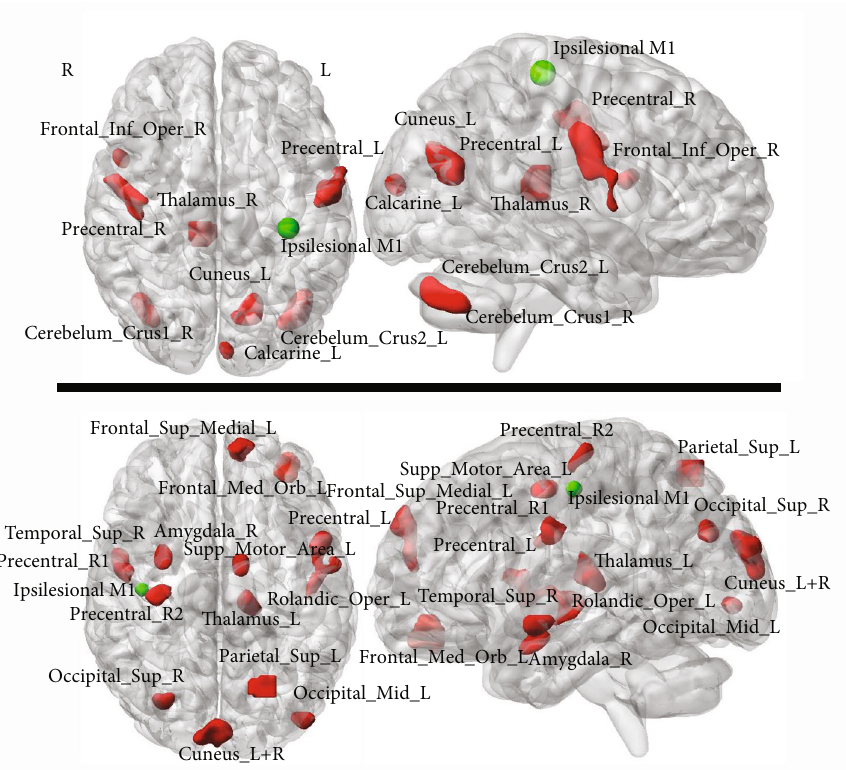
Figure 5: The association between FMA-UE scores and GM volume alterations. (a) Brain regions showing signi fi cant correlations with FMA-UE scores in the left-sided stroke group. (b) Brain regions showing signi fi cant correlations with FMA-UE scores in the right-sided stroke group. The cyan circle is the location of the seed point (the ipsilesional M1). Abbreviations: L=left hemisphere; R =right